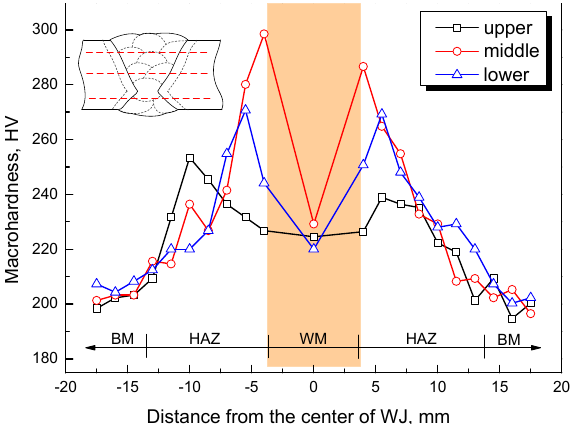
Figure 4. Vickers macrohardness profile across the WJ. There are three measuring lines across the WJ which are illustrated on the top left.